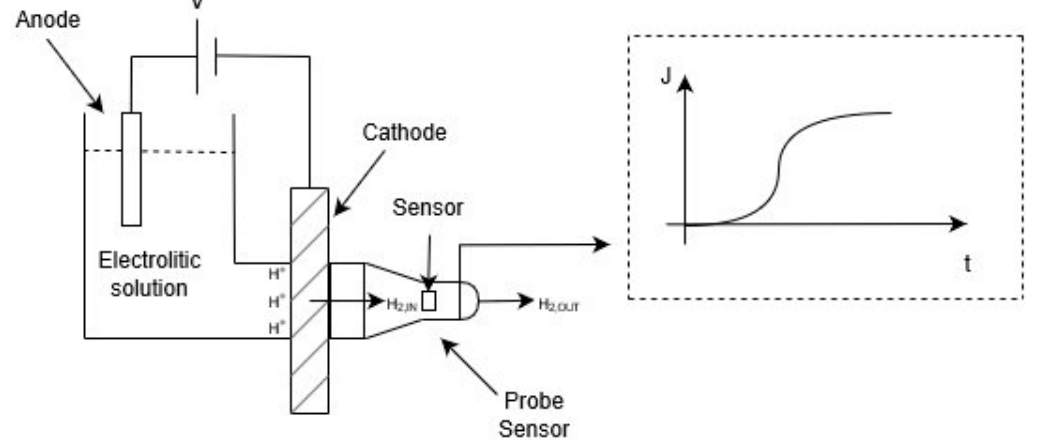
Figure 5. Innovative instrument patented by Letomec S.r.l.